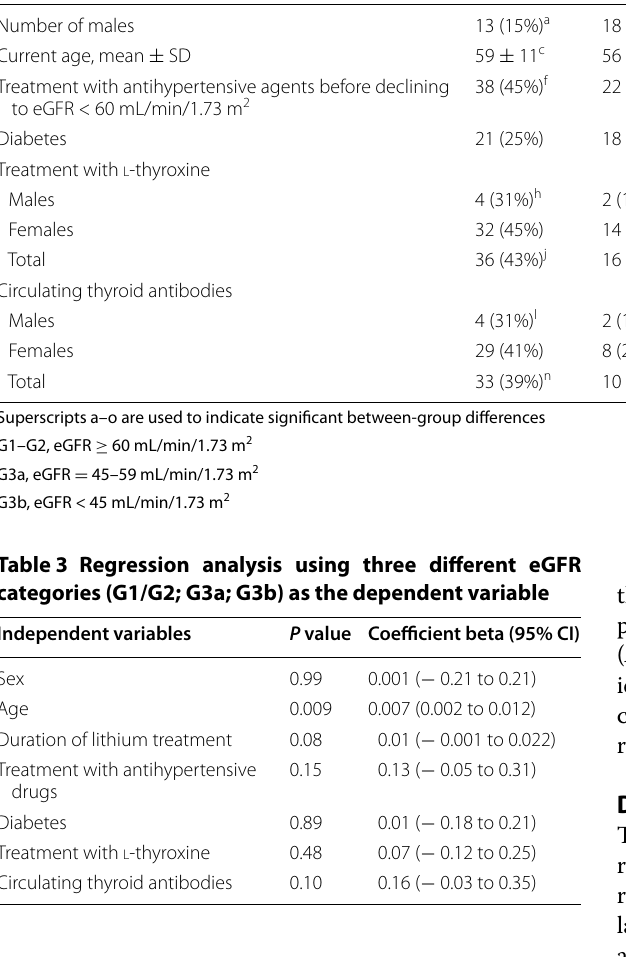
Table 2 Demographic and clinical characteristics by the patient’s final eGFR category